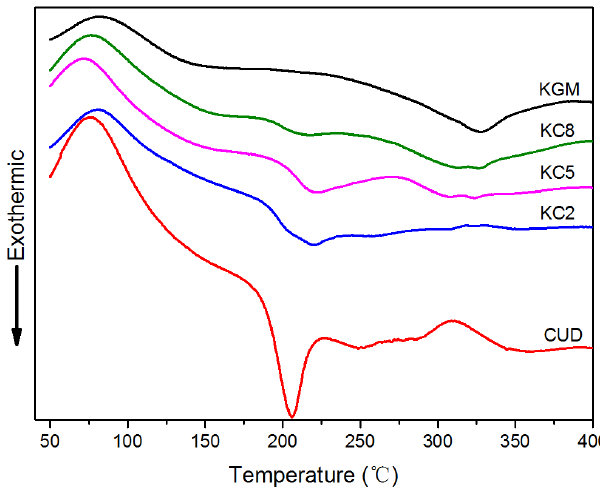
Figure 8. Differential scanning calorimetry ( DSC) profiles of the freeze-dried KGM/CUD blend Figure 8. Di ff erential scanning calorimetry (DSC) profiles of the freeze-dried KGM / CUD blend systems systems at 20–400 °C. at 20–400 ◦ C.